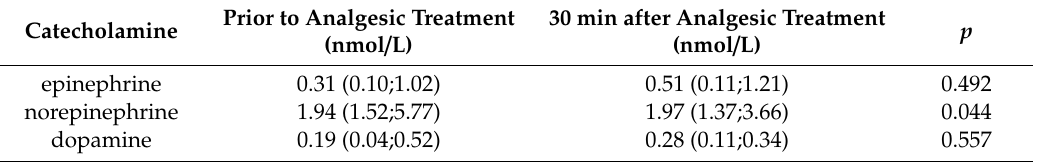
Table 3. Changes of patients’ catecholamine plasma